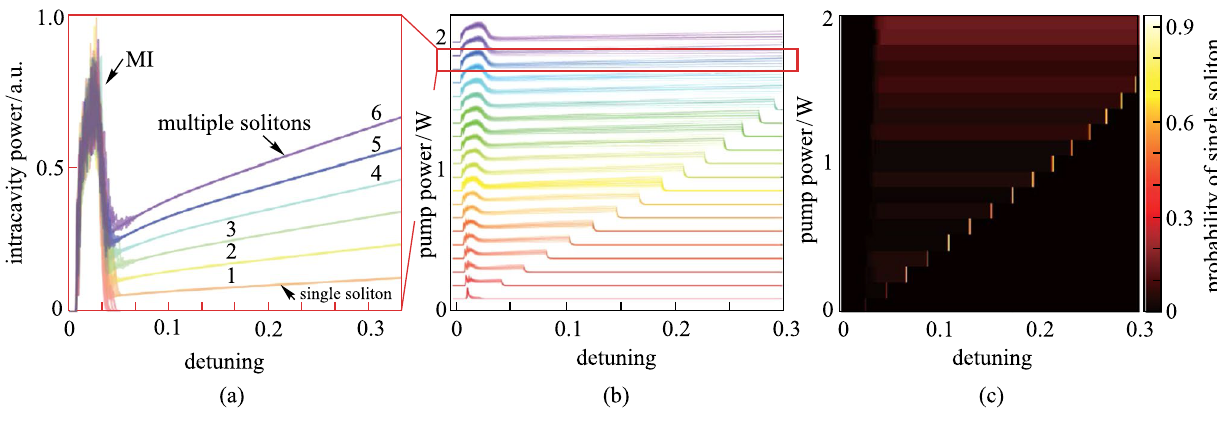
Fig. 4 a Simulations results of intracavity power traces under 1.8 W pump power. SMD is not applied and 100 simulation results are presented. Different intracavity soliton numbers are expressed by different colors. b Superpositions of intracavity power traces. The pump power is changed from 0.1 to 2 W with a step of 0.1 W to capture the soliton existence region. a is an example extracted from ( b ) at 1.8 W pump power, as indi- cated by the red square. c Probability of the single soliton generation vs. pump-resonance detuning and pump power. The parameters used are t = 4.4 ps , L = 628 μm , 𝛼 = 2.4 × 10 − 3 , 𝛽 2 = − 81 ps 2 ∕km , 𝛾 = 1 (W ⋅ m) − 1 , R 7 per of 7.55 × 10 −